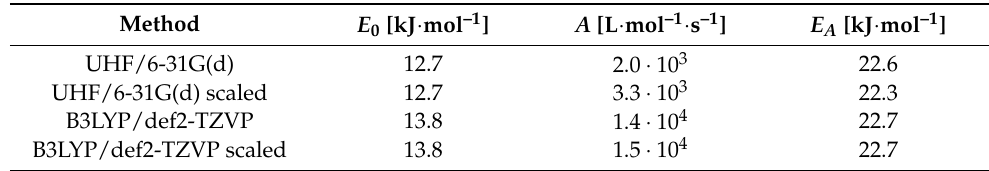
Table 1. Calculated electronic barriers, E 0 , and Arrhenius parameters (prefactor, A , and activation energy, E A ) for the propagation step of DEI at 20 ◦ C. The frequencies used for the calculation were used unscaled as well as scaled by their respective scaling